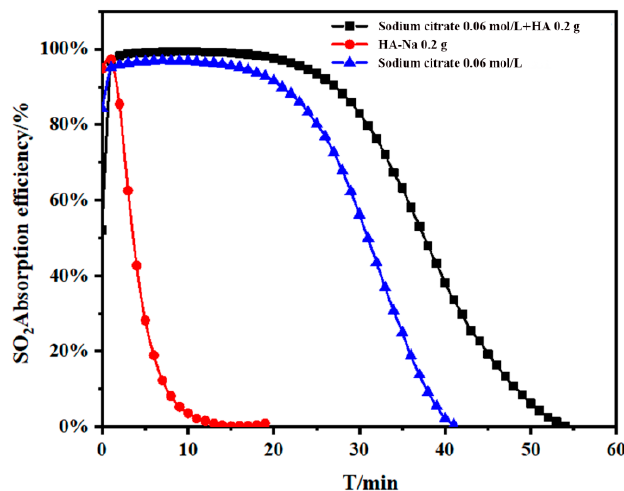
Figure 5. Comparison of HA–Na and Ci-Na solution. SO 2 = 2300 ppm, gas flow = 1.68 L/min, ab- sorption solution = 60 mL and Ci-Na = 0.06 mol/L and 25 ° C.